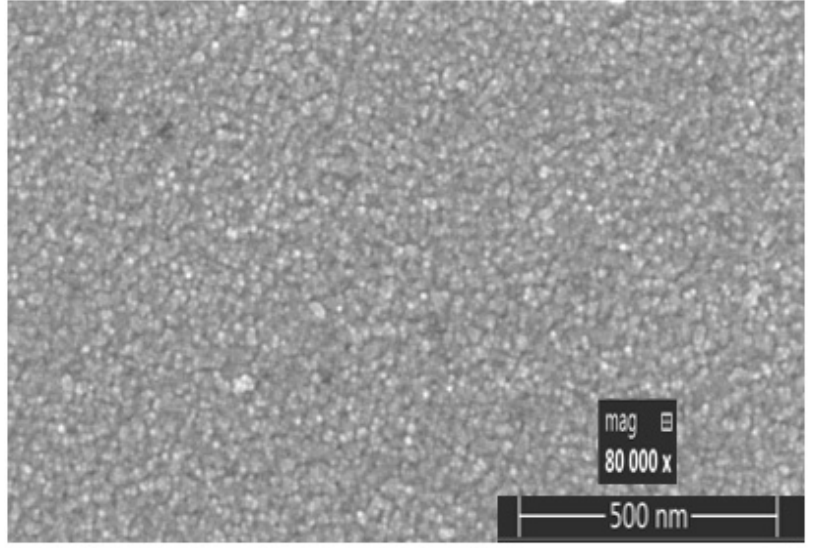
Figure 3. SEM images of the C–Ag nanocomposite thin films deposited on a silicon wafer. The EDAX spectra of one of the ten pieces analyzed are presented in Figure 4a,b, which are consistent with the proposed composition. The results of the EDAX elemental microanalysis of the C–Ag onto copy paper and on the silicon wafer are listed in Figure 4a,b, respectively. The results confirm the presence of all elements occurring in the coatings used (C and silver) including other chemical elements such as C, O, and Cl, corresponding to the was 1.02%, while the variation in the percentage of Ag in the 10 pieces measured was